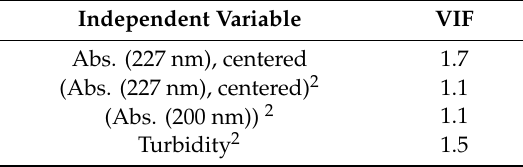
Figure 3. Residuals vs. fitted values for the obtained model: total AOX. Table 3. Variance Inflation Factors (VIFs) for the obtained model: total AOX.